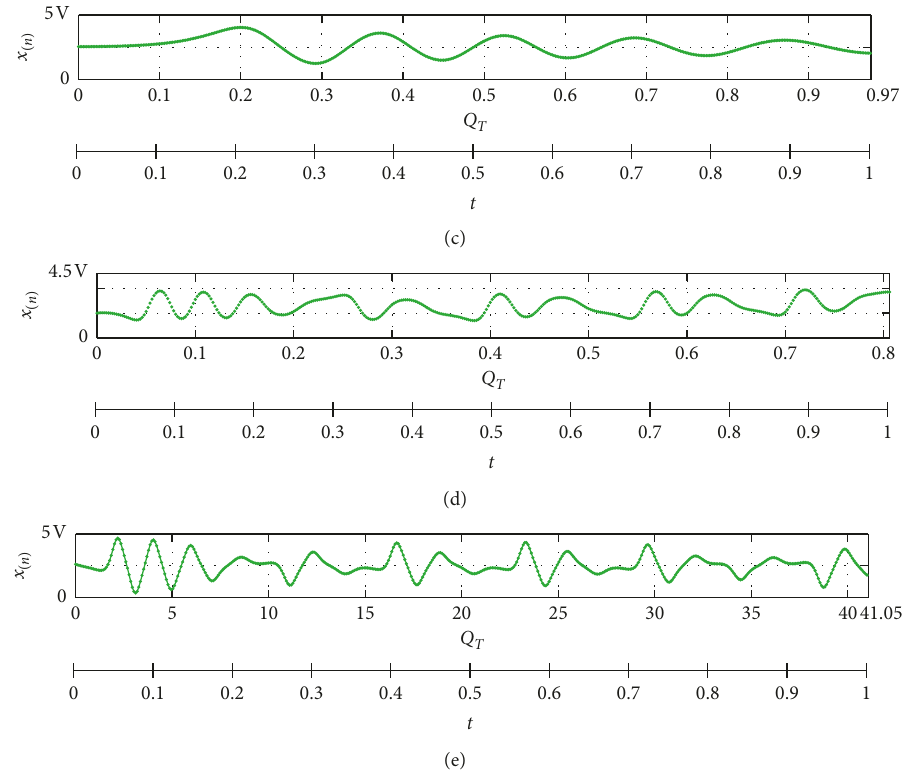
Figure 15: Time series of the five CSs of Lorenz, R¨ossler, Chen, Liu and Chen, and MACM in their DVs by using the Euler NA to compare the performance of version 1 PIC of ES expressed Q T for t � 1 second: (a) x ( n ) of Lorenz, (b) x ( n ) of R¨ossler, (c) x ( n ) of Chen, (d) x ( n ) of Liu and Chen, and (e) x ( n ) of